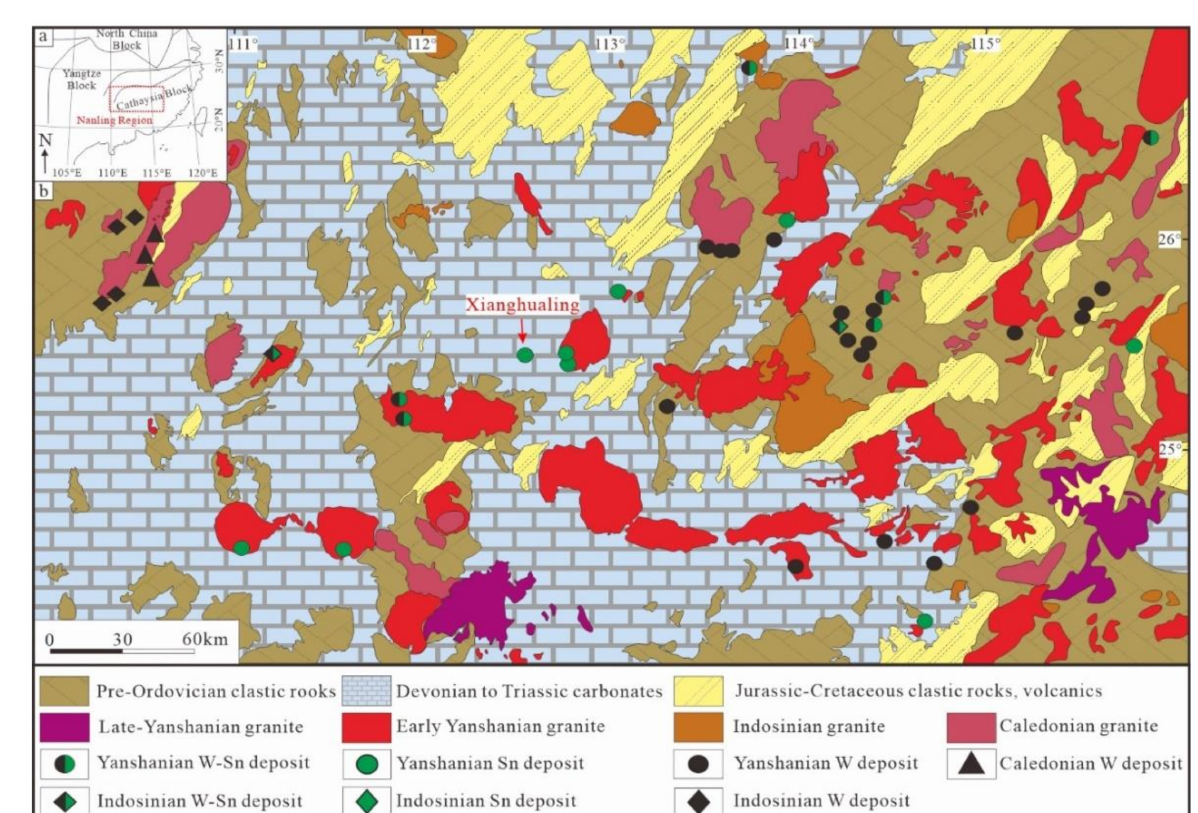
Figure 1. Distribution map of granitic intrusions and major tungsten–tin deposits in the Nanling region. ( a ) Tectonic map of South China; ( b ) Geological map of Nanling